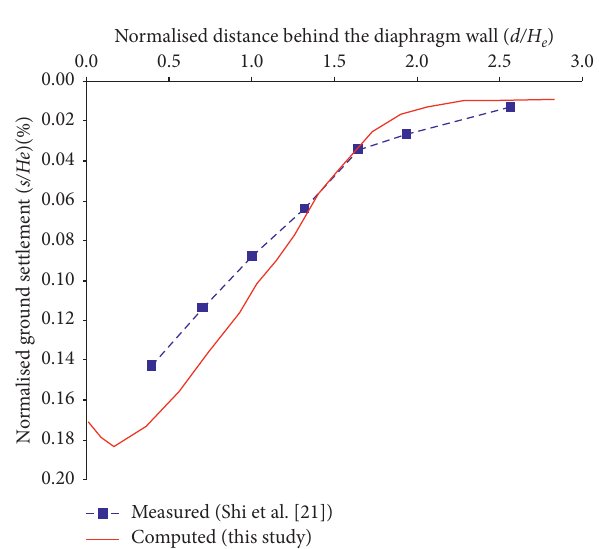
Figure 5: Comparison of the measured and computed ground surface